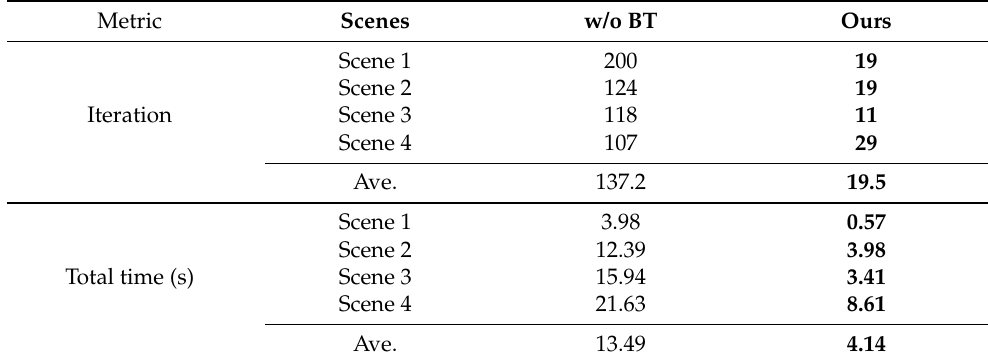
Table 1. Iteration and total time for the motion estimation. The column “w/o BT” represents the result of homographic motion estimation without bird’s-eye view transformation, and the column “ours” represents the estimation result by the proposed method. The top performance is highlighted in bold.